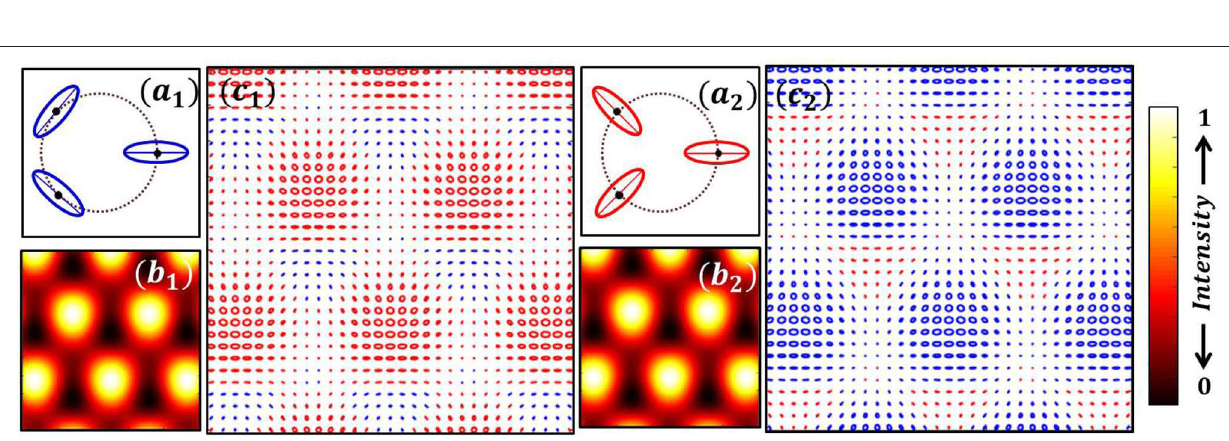
FIGURE 10 | Intensity degeneracy in the interference of three non-coplanar plane waves-SOPs derived from a C-point. Arrangement of SOPs for a positive (a 1 ) and negative ( a 2 ) index C-point; (b 1 ,b 2 ) resultant intensity patterns; (c 1 ,c 2 ) Resultant SOP distribution. Note the degeneracy in the resultant intensity distributions in (b 1 ,b 2 )